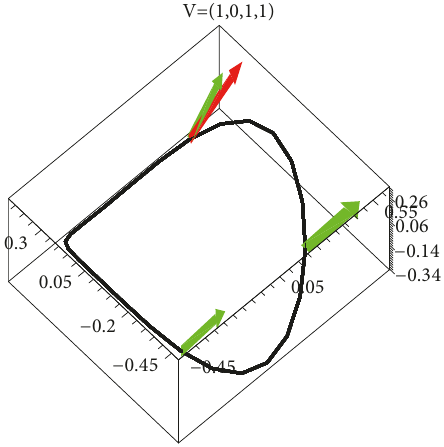
Figure 2: Red vector is 𝛾 󸀠 (0) = {1, −1,0,−2} , and green vectors are magnetic fields 𝑉 = (√3/3){1,0, 1,1} .